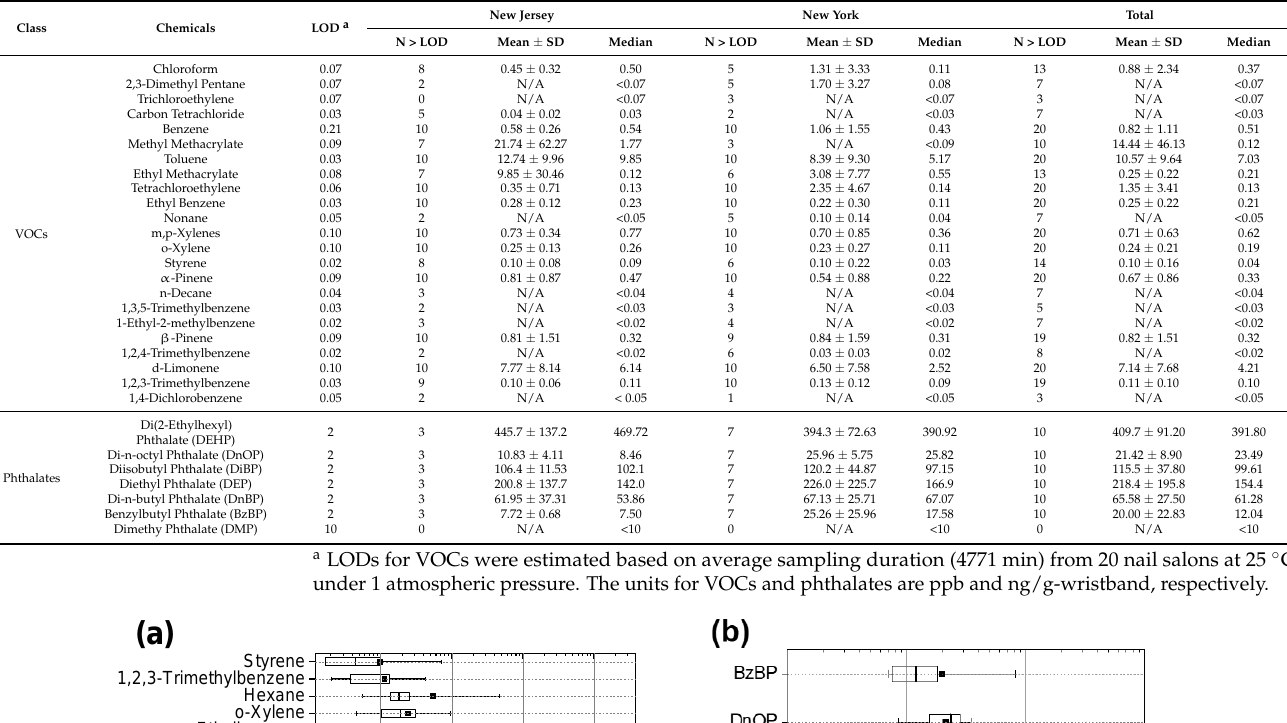
a LODs for VOCs were estimated based on average sampling duration (4771 min) from 20 nail salons at 25 ◦ C under 1 atmospheric pressure. The units for VOCs and phthalates are ppb and ng/g-wristband, respectively.